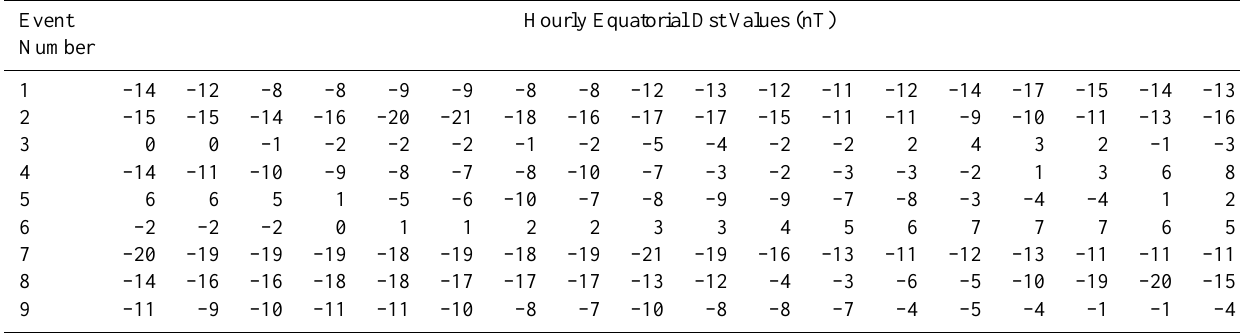
Table 2. Dst Index obtained from Kyoto observatory web page corresponding with the 9 principal events analysed. Event Number